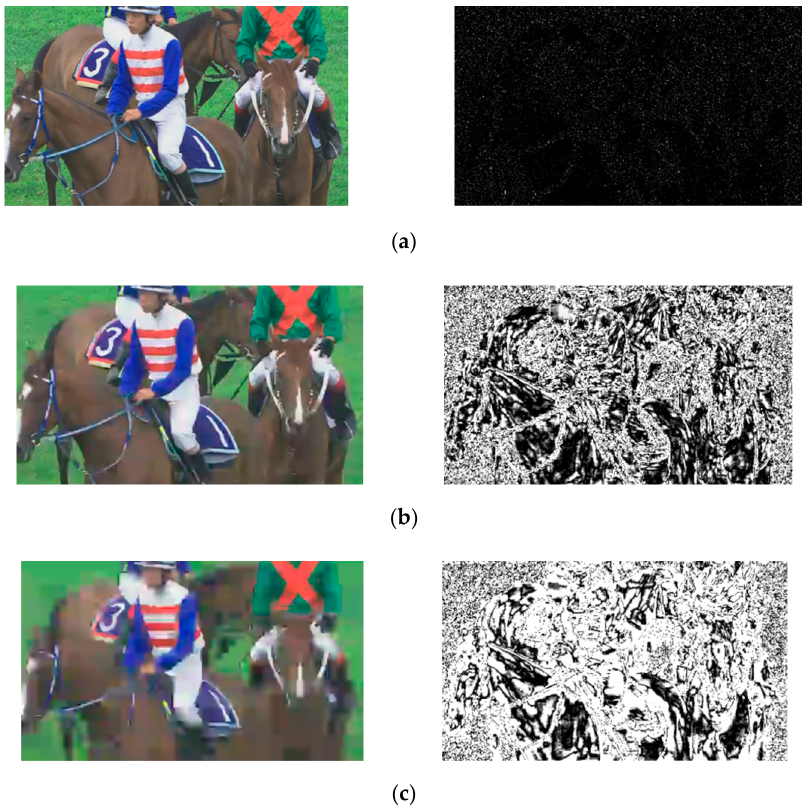
Figure 4. First images in reconstructed video examples compressed with various QPs (left) and difference images between the original and reconstructed images (right). ( a ) Reconstructed image with a QP of 20 and its difference image; ( b ) reconstructed image with a QP of 40 and its difference image; ( c ) reconstructed image with a QP of 50 and its difference image.